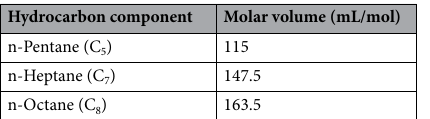
Table 1. Molar volumes of pure hydrocarbons used in the